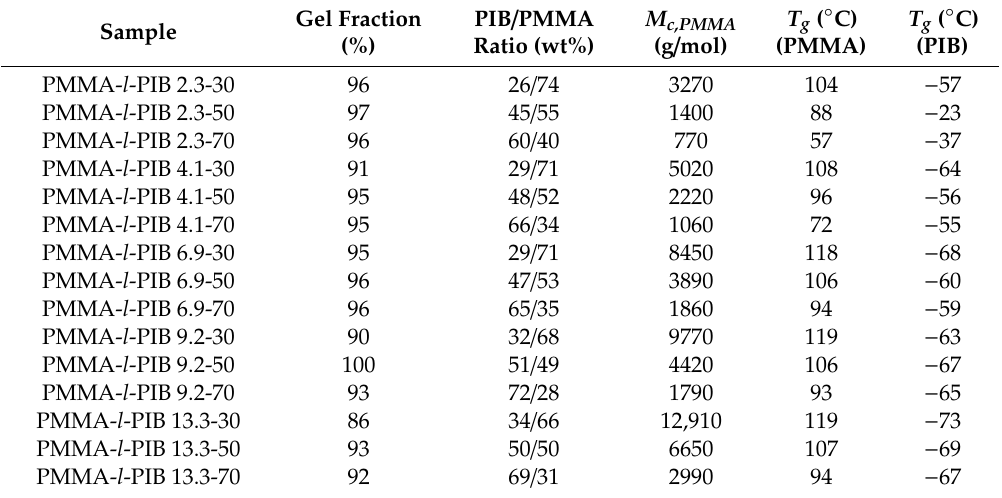
Table 2. The gel fractions, compositions (PIB / PMMA wt% ratios), the average molecular weights between crosslinks ( M c ), and the glass transition temperatures ( T g ) of PMMA- l -PIB conetworks.